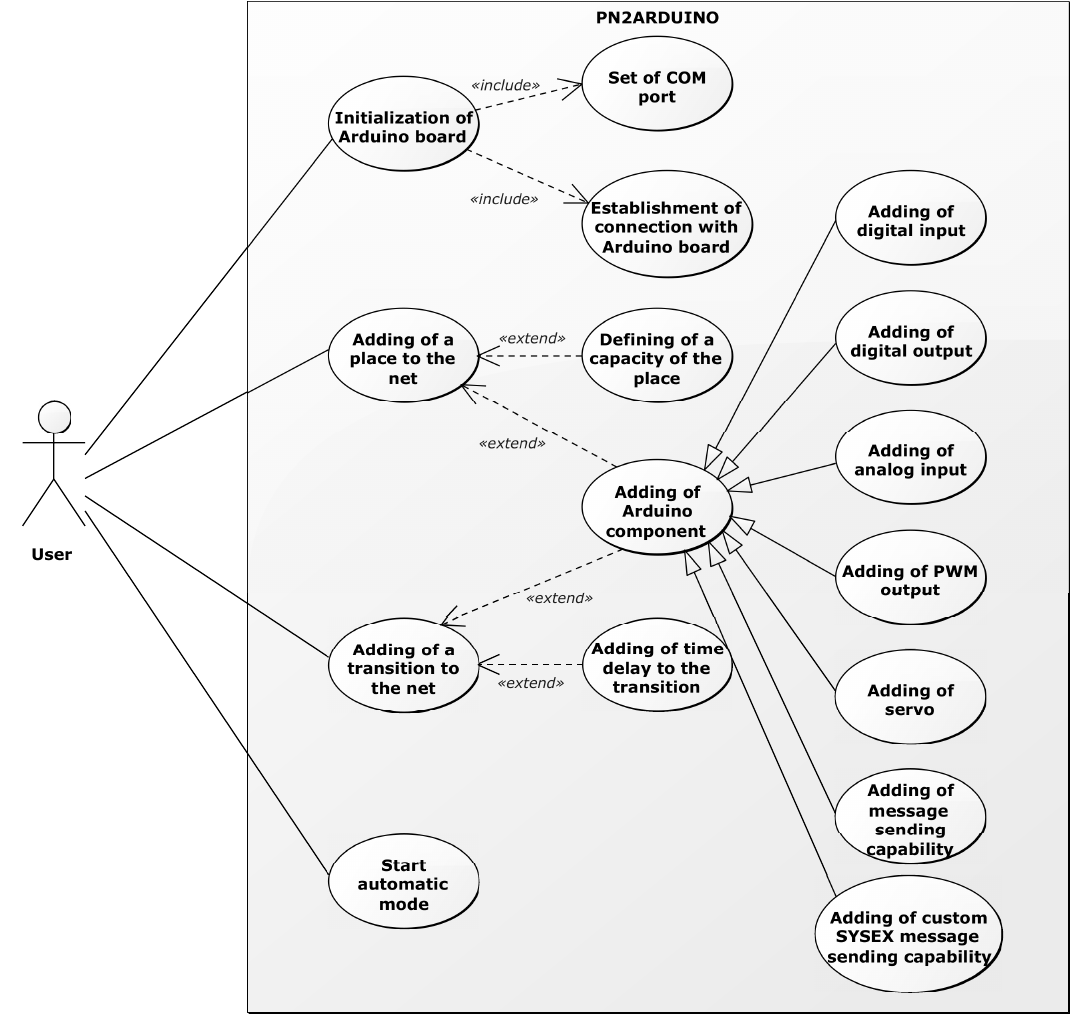
Figure 3. PN2ARDUINO—Use-case